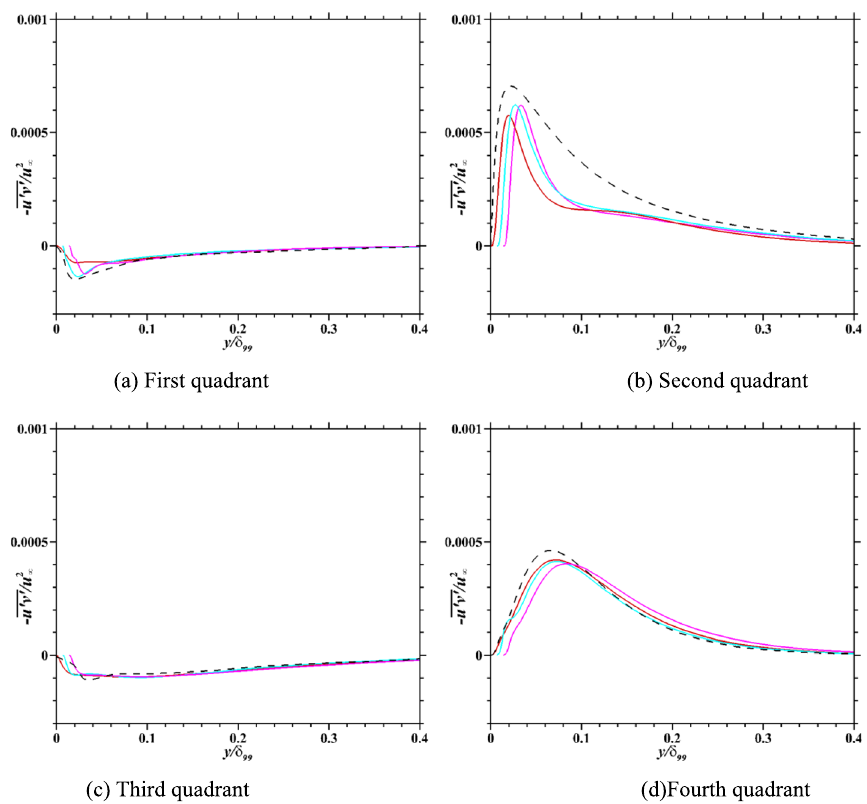
Fig. 14 Reynolds shear stress − u ′ v ′ / u 2 ∞ from each quadrant (The dashed line indicates the smooth flat-plate case and the red, blue and pink colored lines indicate the results in the locations of riblet valley, midpoint and tip). a First quadrant. b Second quadrant. c Third quadrant. d Fourth